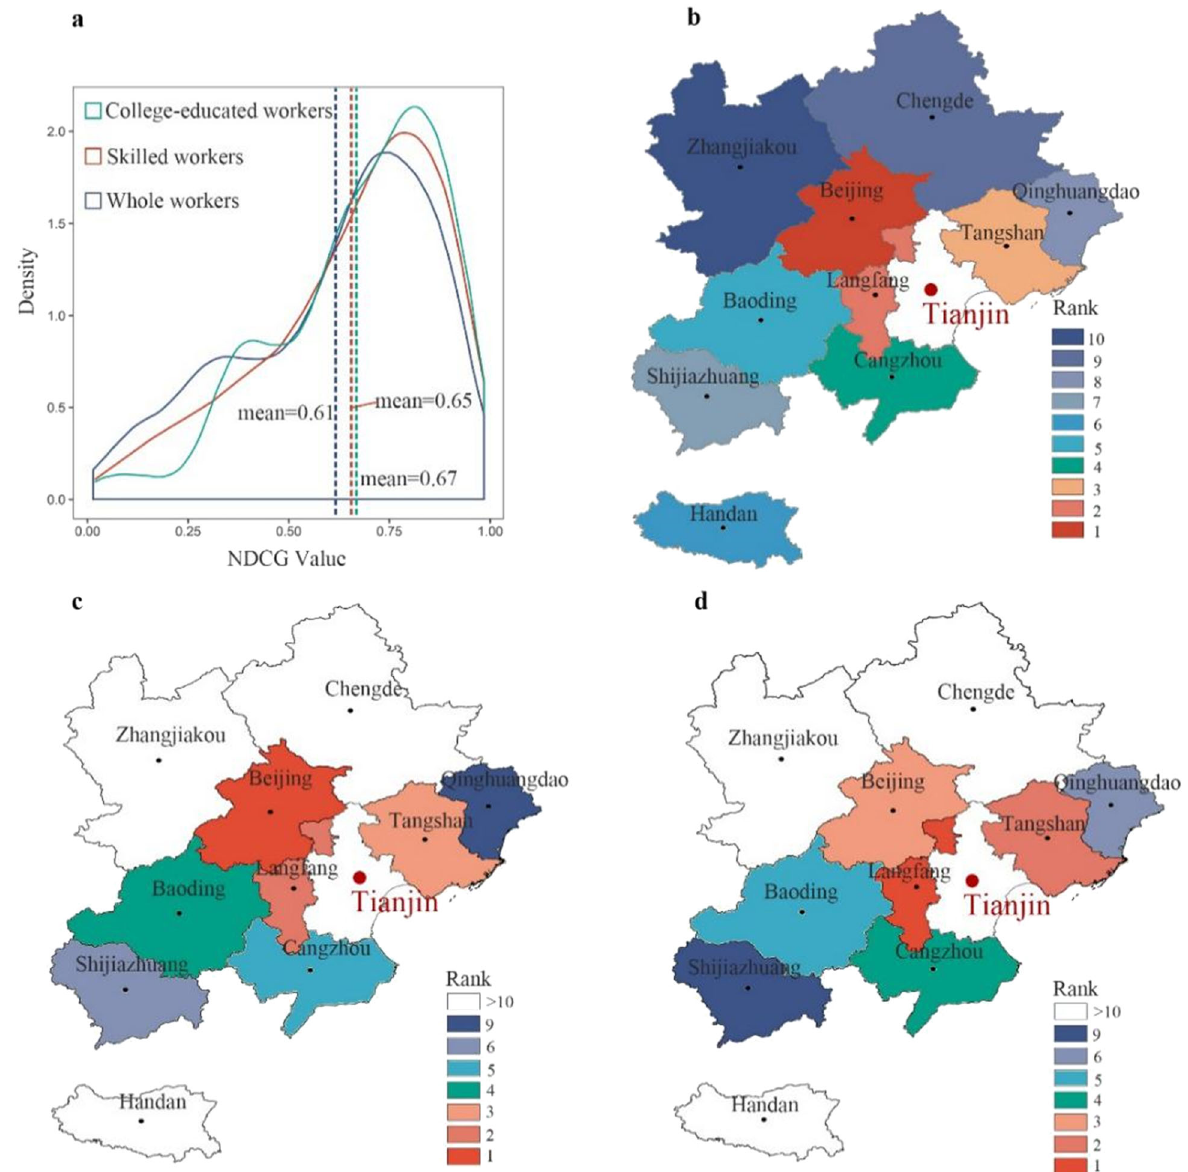
Fig. 6 Radiation models on predicting city-to-city migration patterns. a The distribution of NDCG values of the radiation models based on college- educated workers, skilled workers and total employment respectively. b The top 10 destinations from Tianjin city based on the daily migration data from Baidu Map ® . c The predicted destinations from Tianjin city based on the baseline radiation model using total employment. d The predicted destinations from Tianjin city based on the radiation model using skilled worker